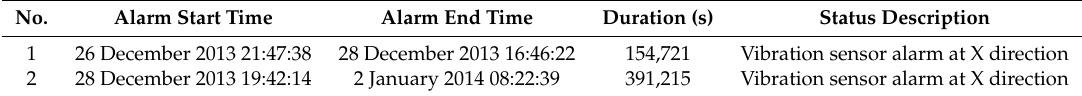
Table 4. Vibration alarm records in the SCADA system in December, 2013.